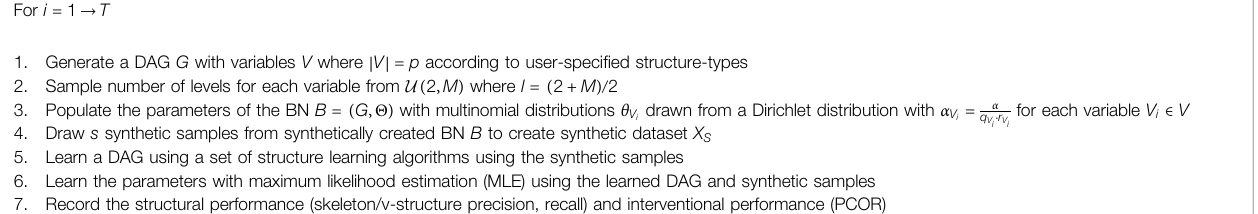
Algorithm 1: CDG-T Overview. Given: (cid:129) The observable properties of a real dataset (sample size n , number of variables p , average levels l ) (cid:129) The unobservable estimates of a real dataset (structure type t , CPT imbalance α ) (cid:129) The number of trials T (cid:129) Hyper-parameters of structure learning